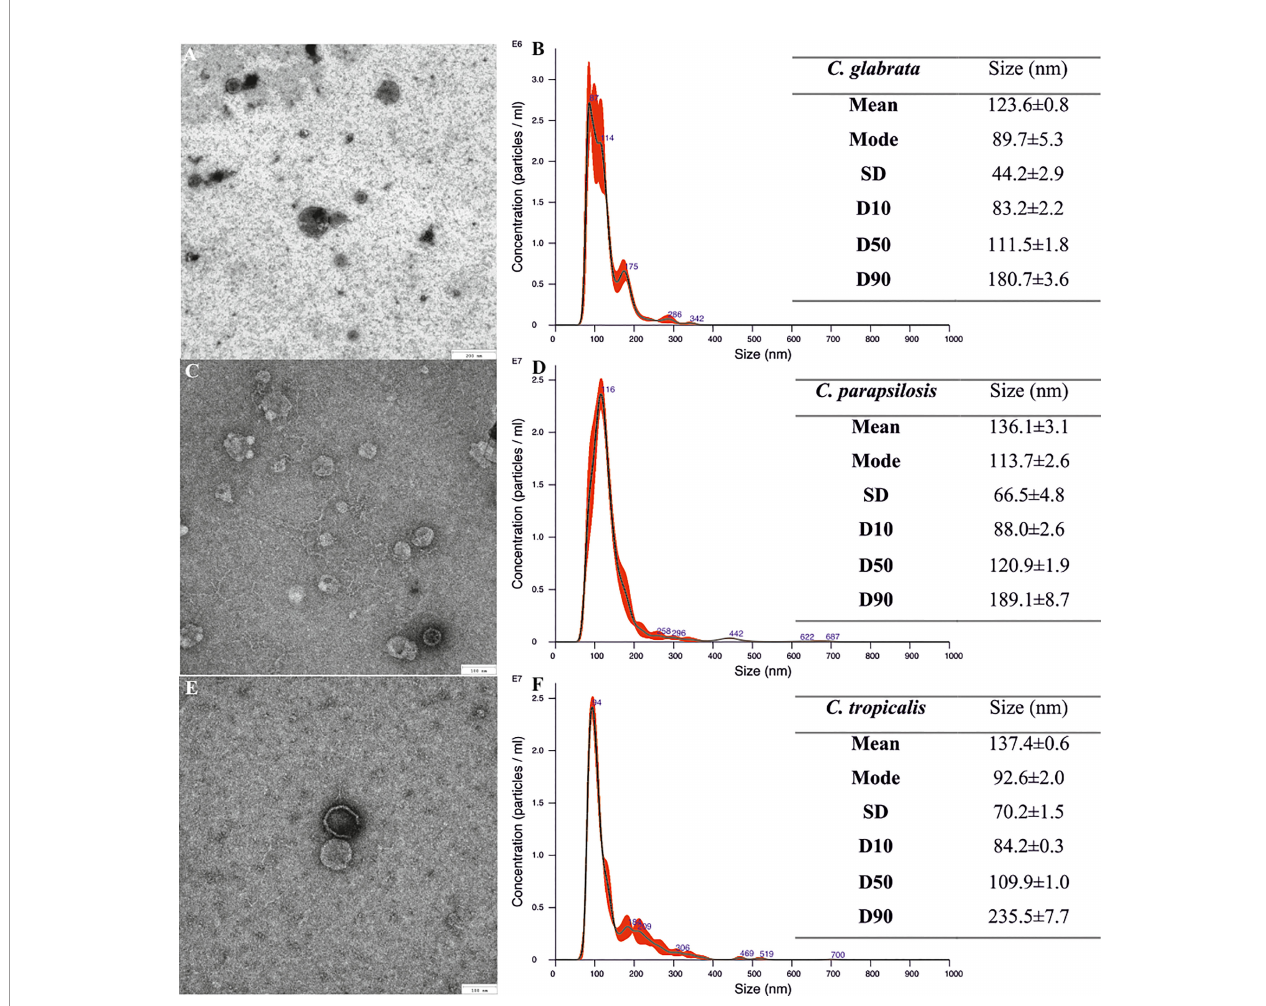
FIGURE 1 | Size characteristics of Candida glabrata , Candida parapsilosis , and Candida tropicalis bio fi lm-derived extracellular vesicles (EVs). TEM images of EVs (A, C, E) and NTA particle size distribution analysis (B, D, F) ; representative histograms of the average size distribution from three measurements of a single sample (black line). Numbers show the maxima of particular peaks and red areas indicate the standard deviation (SD) between measurements. Tables include EVs ’ size parameters measured by NTA; factors D10, D50, and D90 mean that 10%, 50%, and 90% of the EV population had a diameter of less than or equal to the given value. Data are presented as means ±